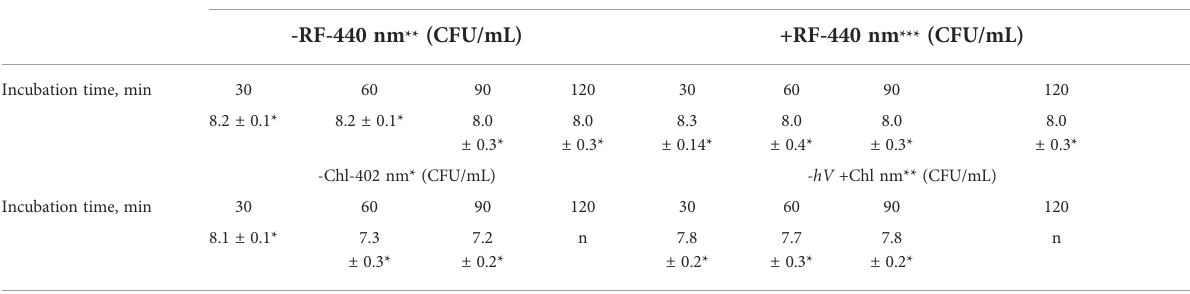
TABLE 3 CFU counts of dark controls (reported in log 10 scale) of the bio fi